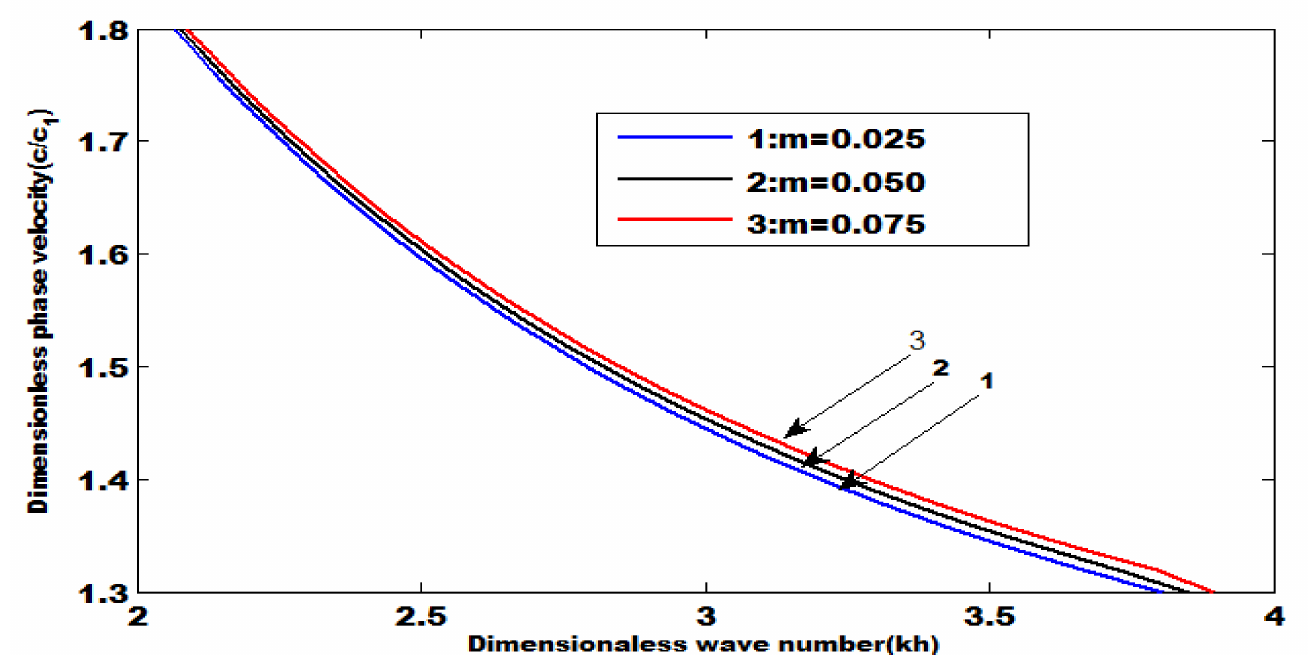
Figure 1. The phase velocity with wave number when a 1 = 0.1, α = 0.2, β = 0.1, h = 0.04, p = 0.01, a 2 = 0.2.